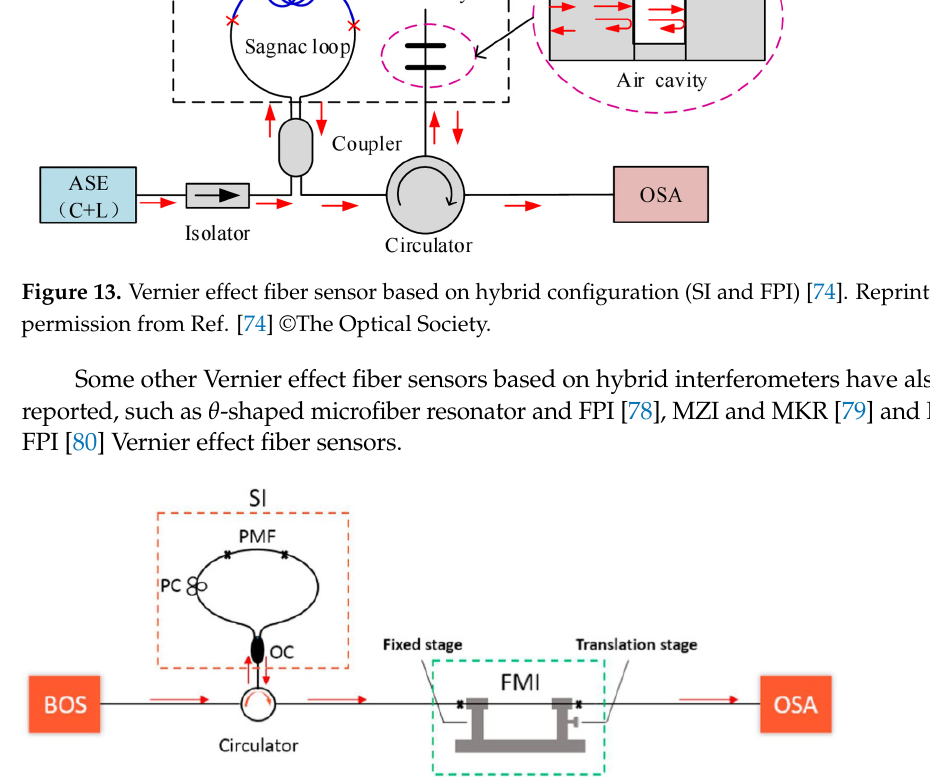
Figure 14. Vernier effect fiber sensor based on hybrid configuration (SI and MZI) [76]. Reprinted with permission from Ref. [76]